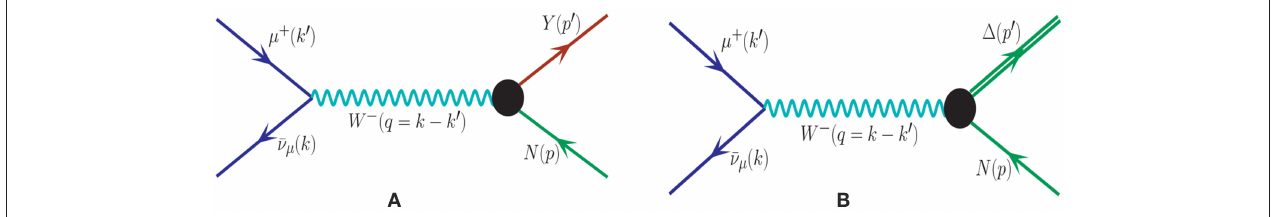
N ( p ) ν µ ( k ) µ + ( k ′ ) 1 ( p ′ ) (right). The quantities in the bracket ¯ + −→ +